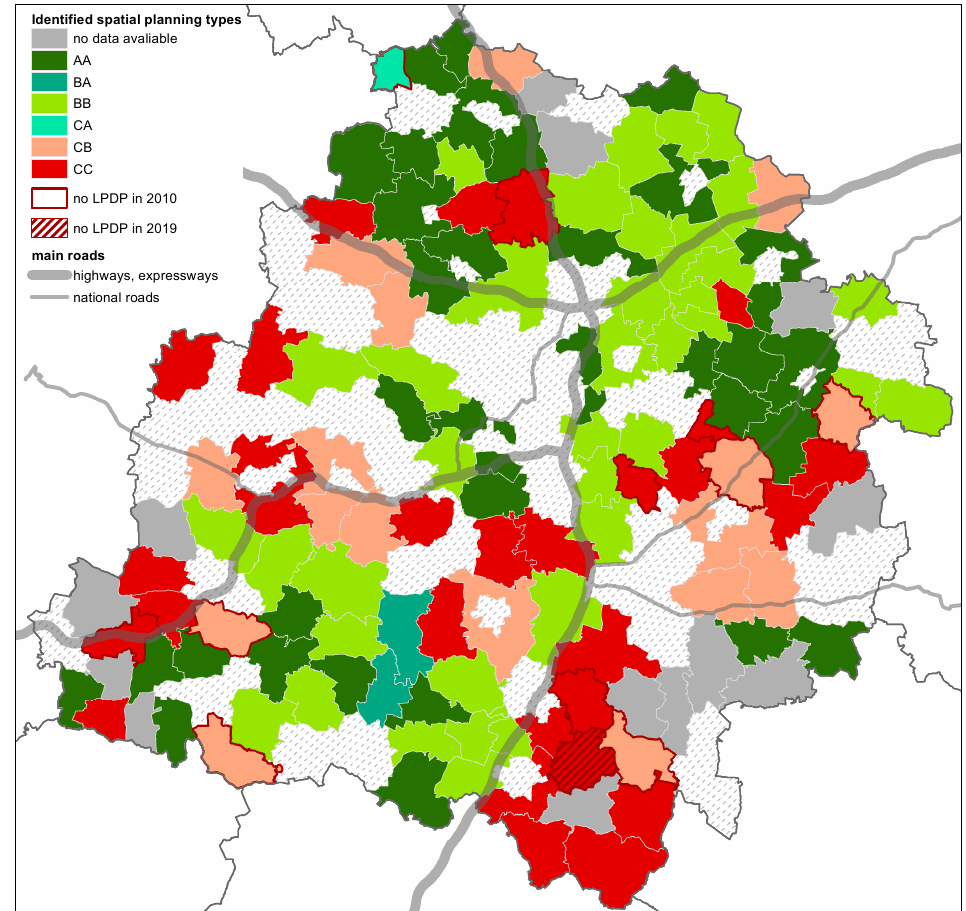
Figure 4. Spatial diversification of the planning process in rural gminas of Łód´z voivodeship. Source: based on data from Statistics Poland